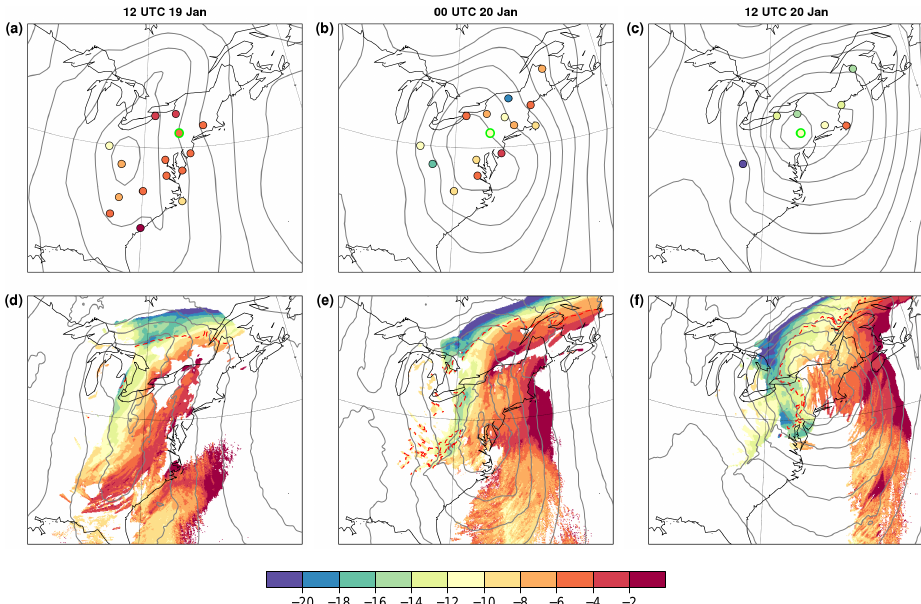
Fig. 5. δ 18 O in six-hourly accumulated precipitation (colours, in ‰) at (a, d) 12:00UTC 19 January, (b, e) 00:00UTC 20 January and (c, f) 12:00UTC 20 January. As above, data are shown for periods three hours before to three hours after the respective dates. Panels (a–c) contain station observations from GL90, (d–f) show results from the COSMO iso reference simulation. For the latter, data are only shown where the simulated six-hourly accumulated precipitation is larger than 0.6mm. Grey contours show the sea level pressure (contour interval 4hPa) from ERA40 reanalyses (a–c) and COSMO iso (d–f) . The station AVP is marked with a green outer circle in panels (a–c) . The red dashed lines in (d–f) indicate the transition between rain and snow at the